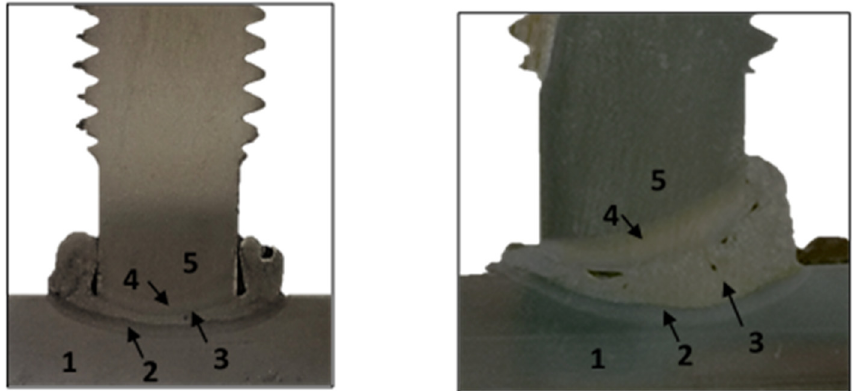
Figure 5. Macrograph of the T8 M20 4.8 welded stud (left) and T8 M20 K800 (right).